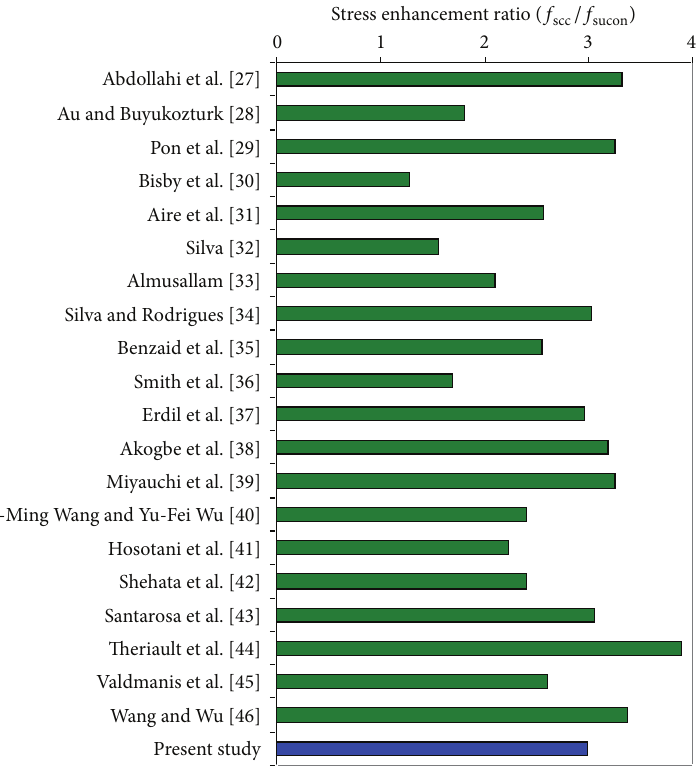
Figure 16: Stress enhancement ratio of present and previous studies, comparison.